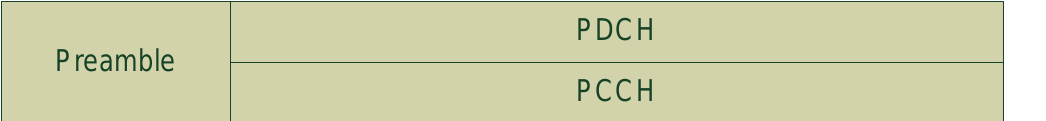
Figure 3. The uplink burst and its constituent parts.